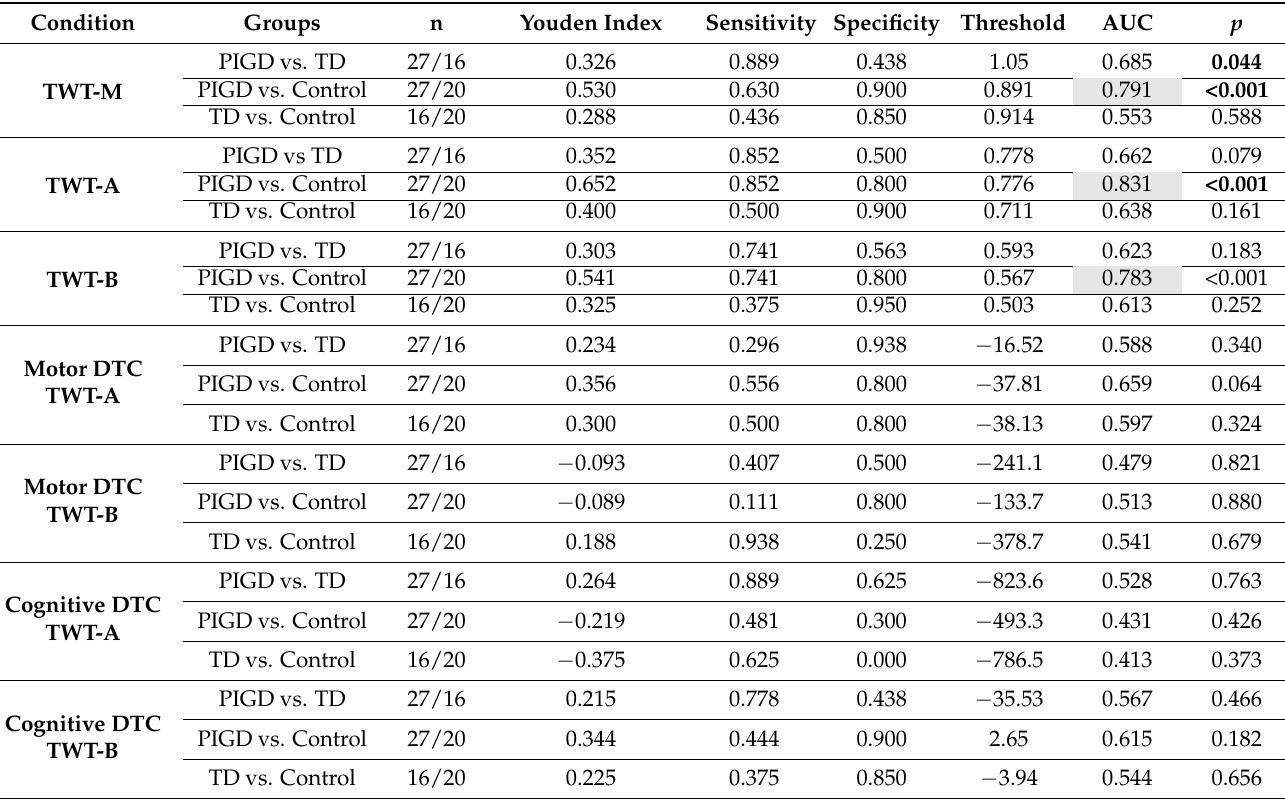
Table 6. Statistics and receiver operating characteristic curve thresholds for the TWT (velocities in the TWT; motor DTC) to differentiate between PIGD, TD, and the control